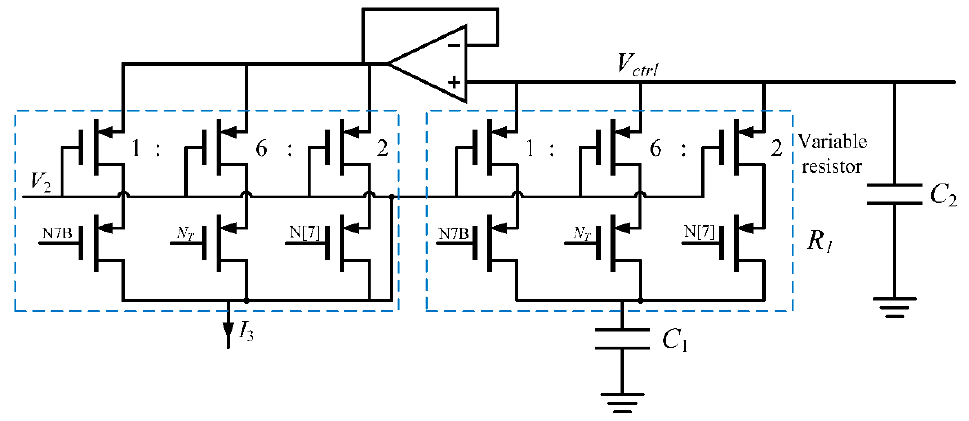
Figure 4. The LPF with a variable resistor.